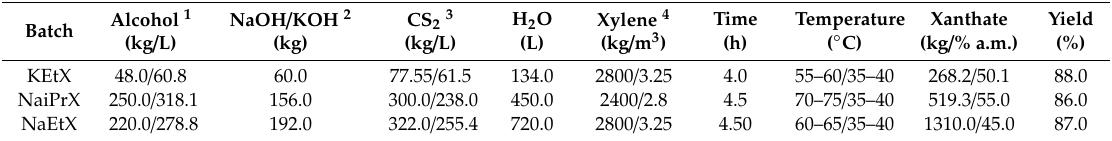
Table 10. Results of synthesis of alkali alkyl xanthates at industrial-level production.